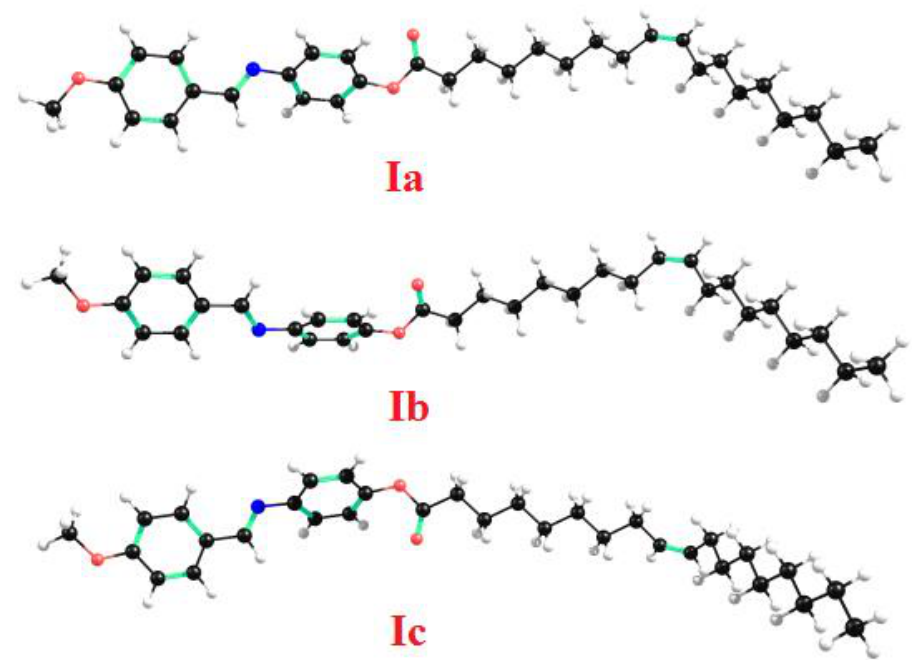
Figure 14. Calculated molecular geometry of the proposed configurational isomers, Ia – c . Table 3. Dimensional parameters and aspect ratios of estimated geometrical isomers of I .